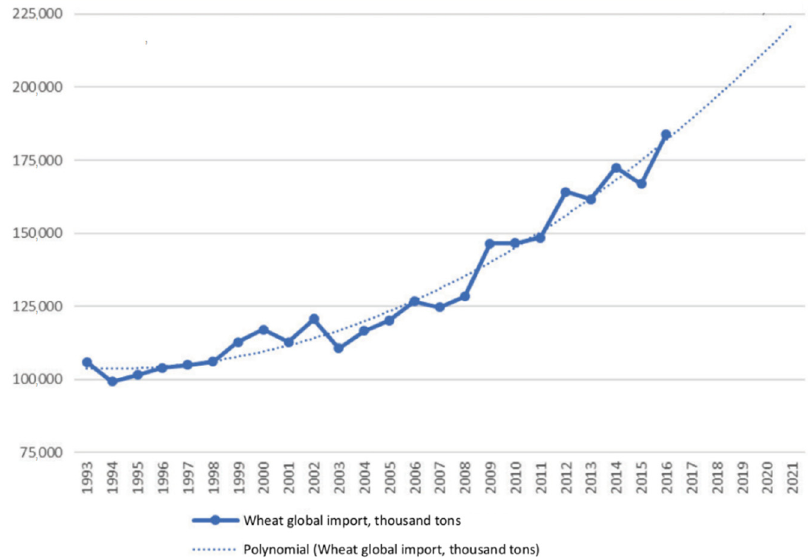
Figure 3. Annual global wheat import and its global trend (UN Comtrade data). Therefore, we enhance our models with a stationary term (1).